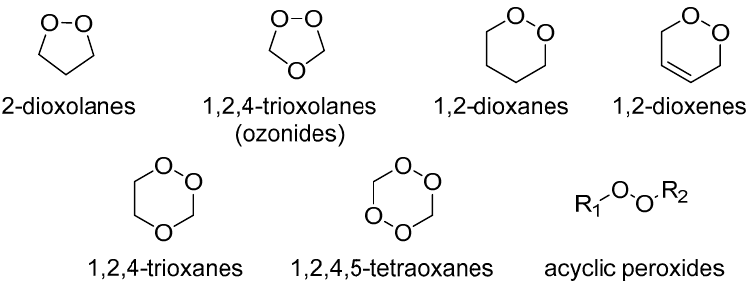
Figure 2. Reviewed cyclic and acyclic peroxides.